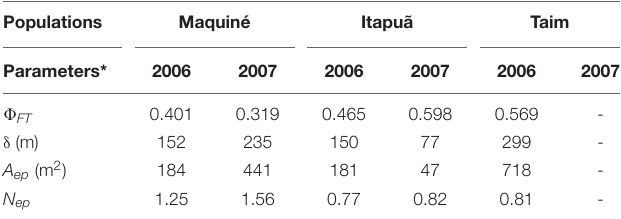
*TwoGener model parameters: pollen structure parameter ( (cid:56) FT ); average distance of pollination ( δ ); effective neighborhood pollination area (A ep ); and effective number of pollen donors (N ep